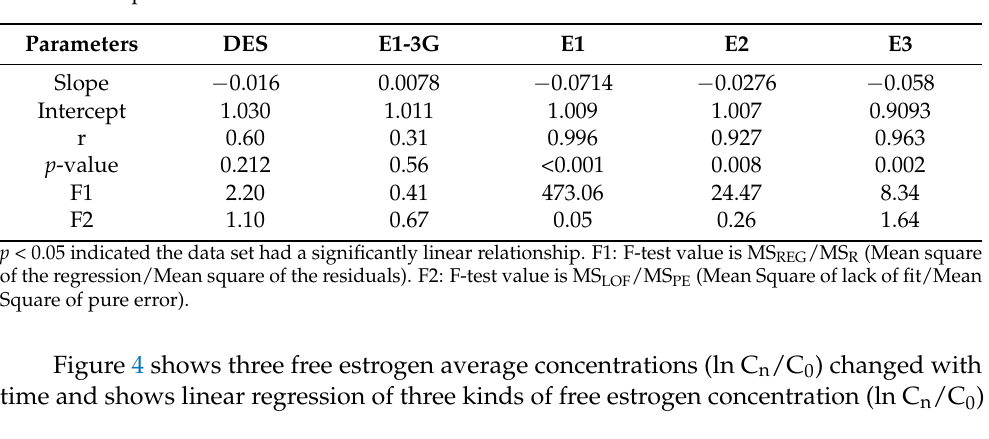
Figure 3. Estrogen concentration ratio (C n /C 0 ) changed with time and linear regression curves for the five detected compounds. Table 4. The parameters of linear regression of average C n /C 0 ratios changed with time for the five detected